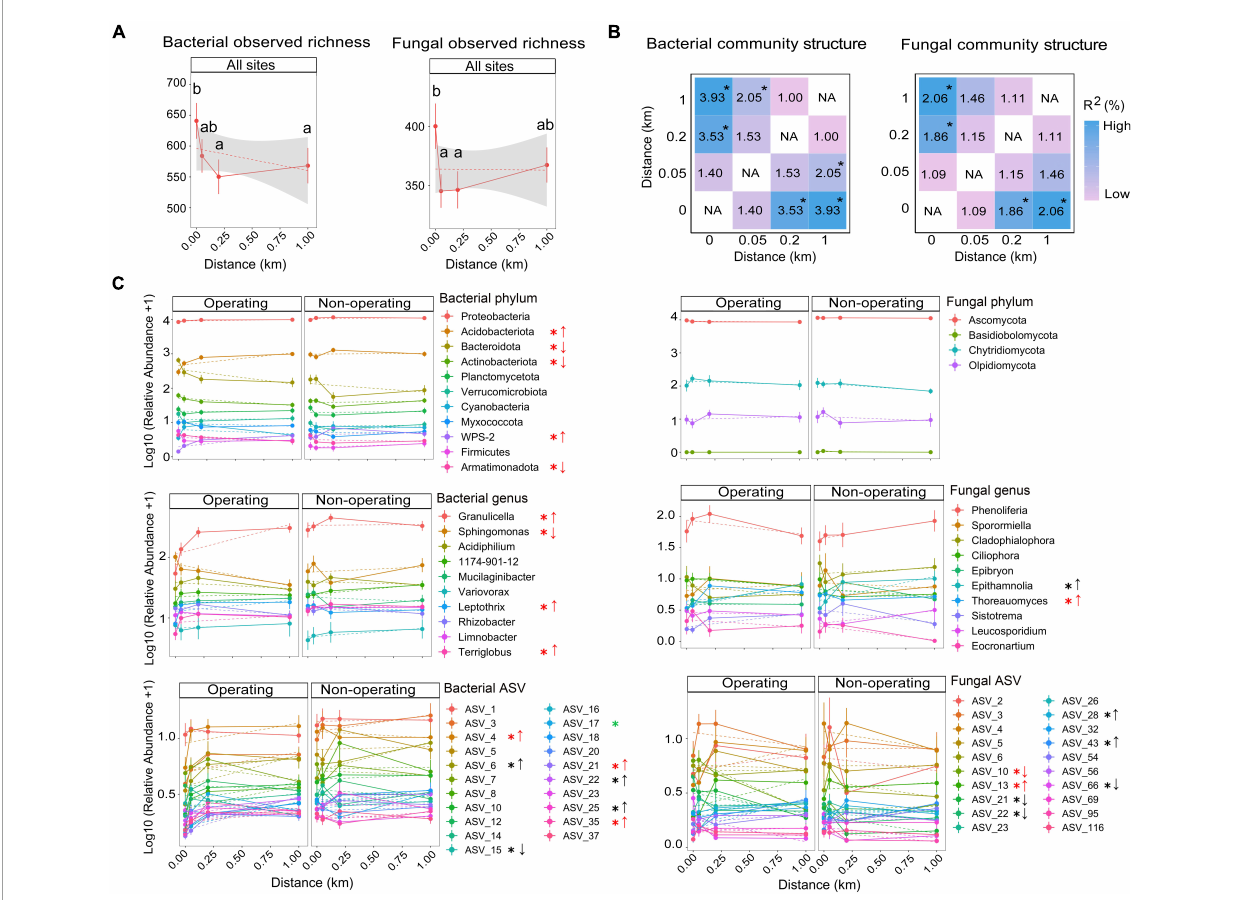
FIGURE6 Changes in phyllosphere microbial communities with distance from mine sites. (A) Bacterial and fungal observed richness. Different lowercase letters indicate significantly different means between different distances at 0 ( N = 39), 0.05 ( N = 44), 0.2 ( N = 43), and 1 km ( N = 44) from mine sites (results based on generalized linear mixed models and Tukey HSD pairwise comparisons, α = 0.05). (B) Bacterial and fungal community structure differences between distances based on the results of pairwise PERMANOVA on Bray-Curtis dissimilarity matrices, * P < 0.05. (C) Relative abundance of bacterial and fungal taxa along the distance at phylum, genus and ASV levels. Points show means for relative abundance after log (x + l) transformation; bars show standard error (SE). Black asterisks indicate significant association with distance at both mining stages based on the zero-inflated beta mixed regression models and post-hoc tests with Tukey HSD pairwise comparisons. Red asterisks indicate the interaction between the distance and mining stage was significant and the effects occurred near operating mines, while green asterisks indicate the effects occurred near non-operating sites. Arrows used for linear patterns: up arrows, relative abundance is increasing with the distance; down arrows relative abundance is decreasing with the